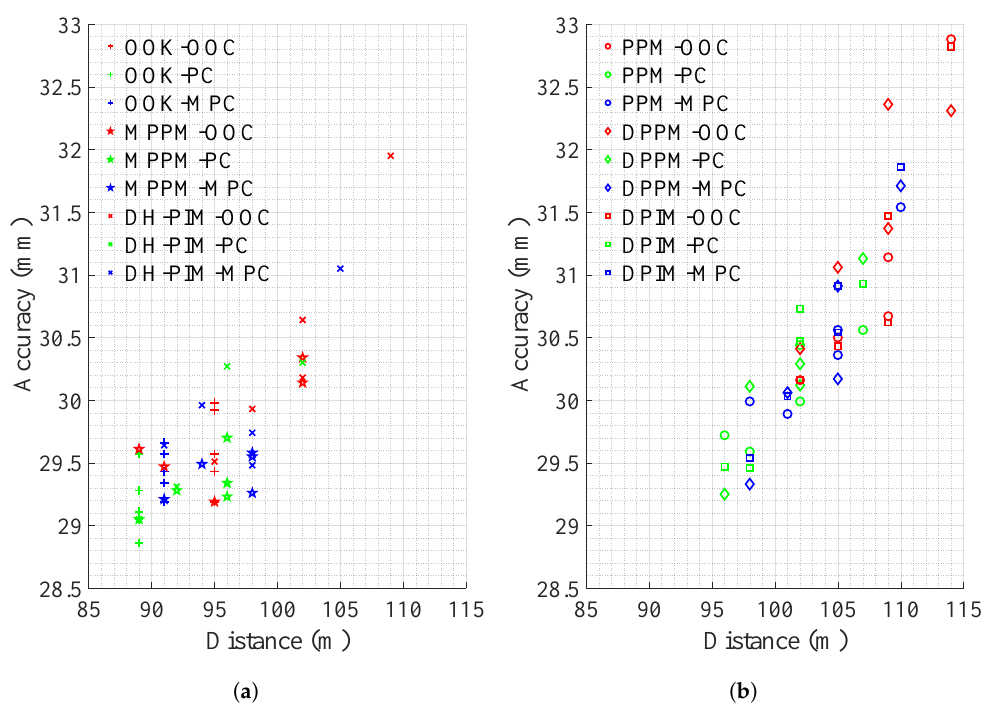
Figure 4. Relationship between the maximum distance and accuracy: ( a ) the combination of using OOK, MPPM, and DH-PIM; ( b ) the combination of using PPM, DPPM, and